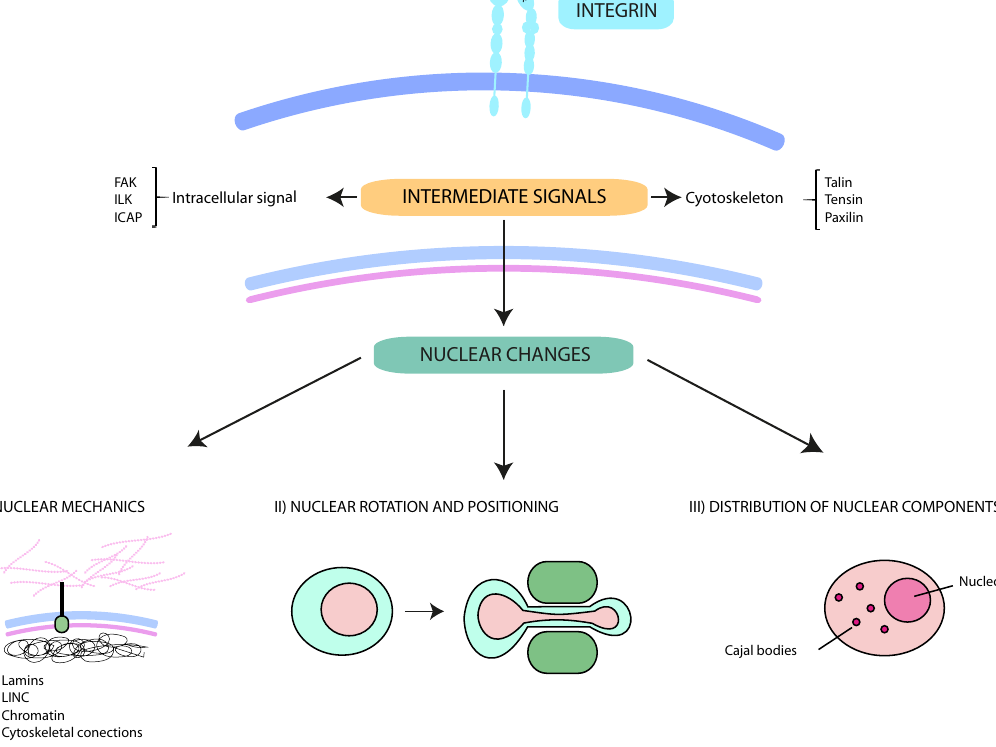
Figure 1. Schematic representation of the interplay between integrins and nuclear changes. Multiple external stimuli from the tumor microenvironment control integrin-mediated signals. The cytoskeleton and protein kinases transmit these signals from the cell surface into the nucleus. These downstream pathways contribute to (I) nuclear mechanics and deformability (mainly regulated by lamins, LINC (Linker of nucleoskeleton and cytoskeleton) complexes, the perinuclear cytoskeleton and the chromatin); (II) the rotation and movement of the nucleus (critical for specific cell migration types, such as lobopodial migration); and (III) the intranuclear disposition. Together, the interplay between integrins and nucleus support cancer cell migration and dissemination through constricted